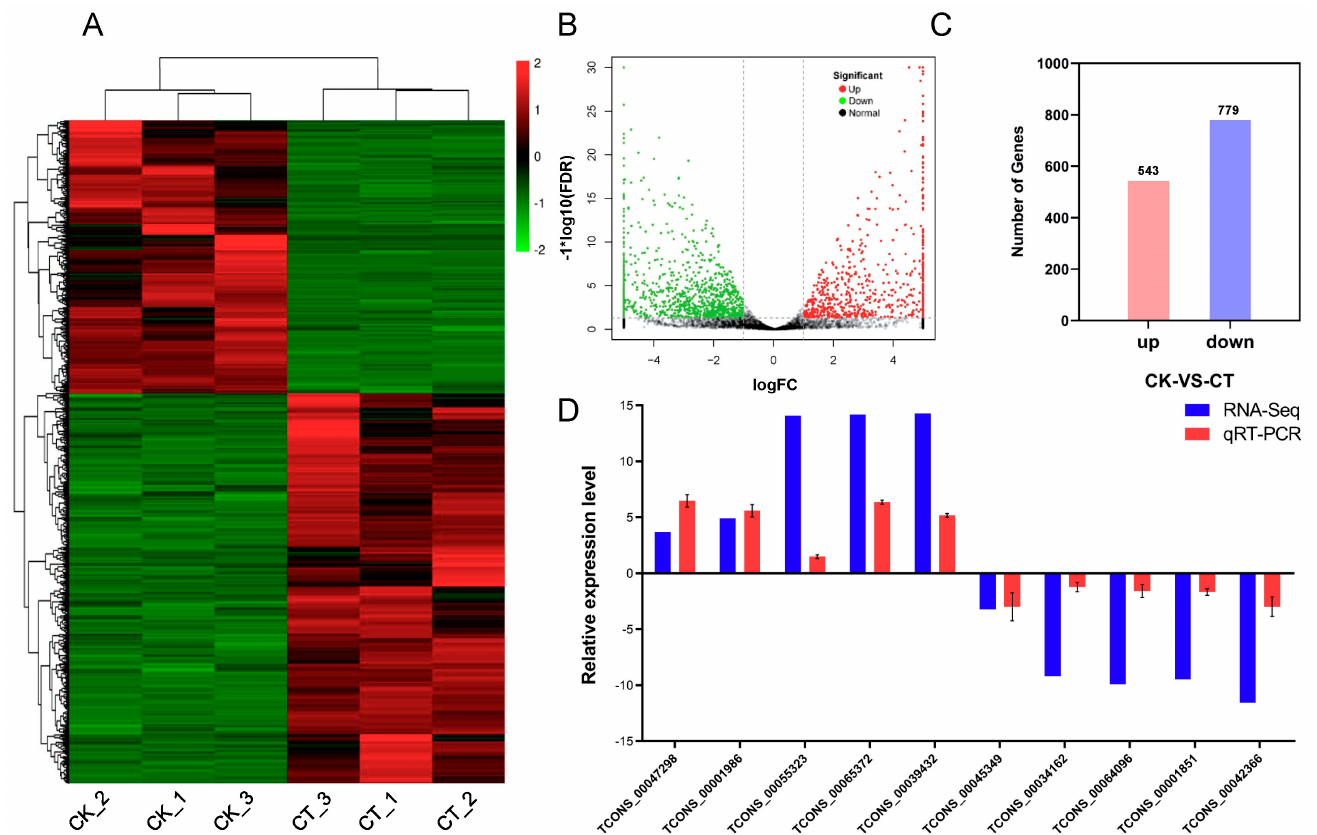
Figure 5. Differentially expressed lncRNAs under cold stress in A. nanus . ( A ) Heatmap of differen- tially expressed lncRNAs. ( B ) Volcano plot of differentially expressed lncRNAs. ( C ) Number of dif- ferentially expressed lncRNAs with up-regulated or down-regulated change patterns. ( D ) qRT-PCR verifies the change patterns in lncRNAs under cold stress. The blue bar graph represents the relative expression level in lncRNA sequencing, and the red bar graph represents the result of qRT-PCR. Each experiment was performed in three independent biological replicates, and the error bar shows the SD.